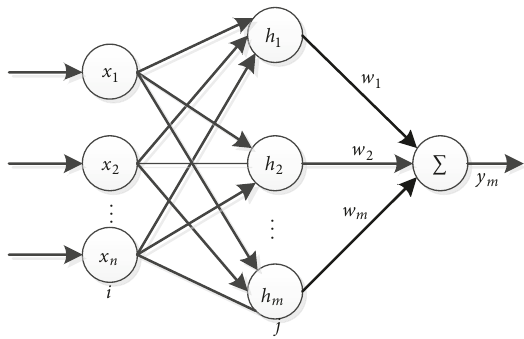
Figure 2: The RBF network with multiple inputs and single